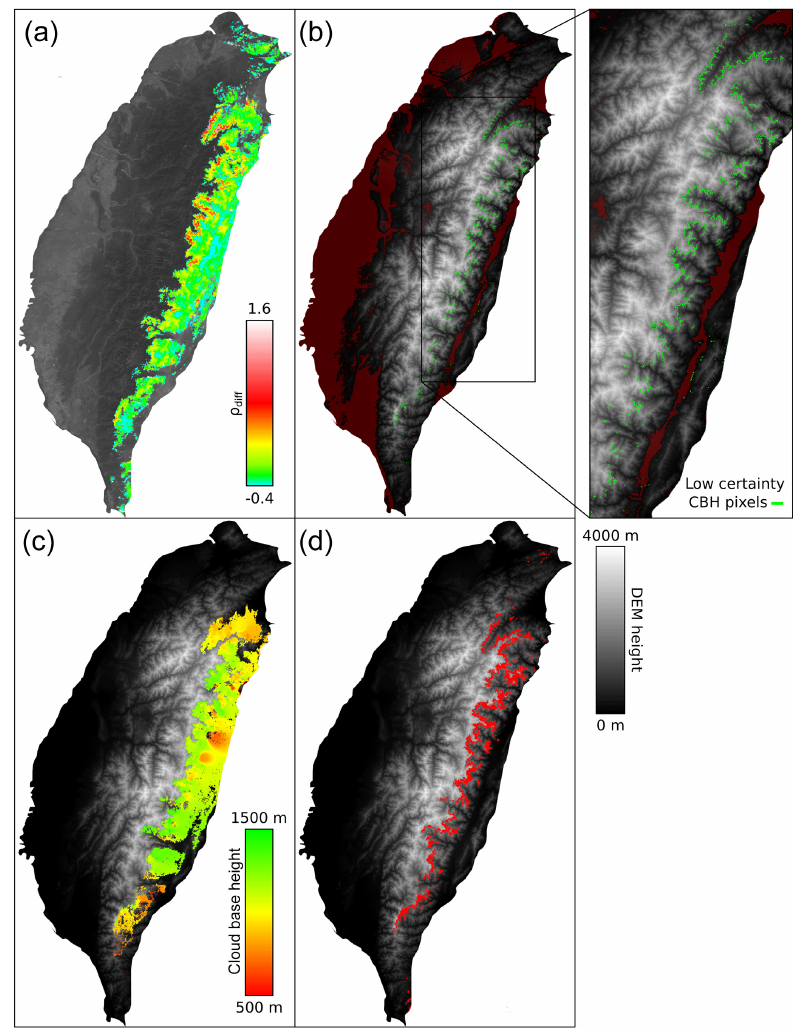
Figure 10. Steps in the calculation of the DOGMA fog mask for the same MODIS overflight as shown in Fig. 2 (5 January 2014, 10:35UTC + 8). (a) ρ diffp calculated for each pixel of the 250m cloud mask. (b) Low-certainty CBH pixels. The dark red area is not steep enough to apply DOGMA. (c) IDW interpolated cloud base height. (d) Final DOGMA ground fog